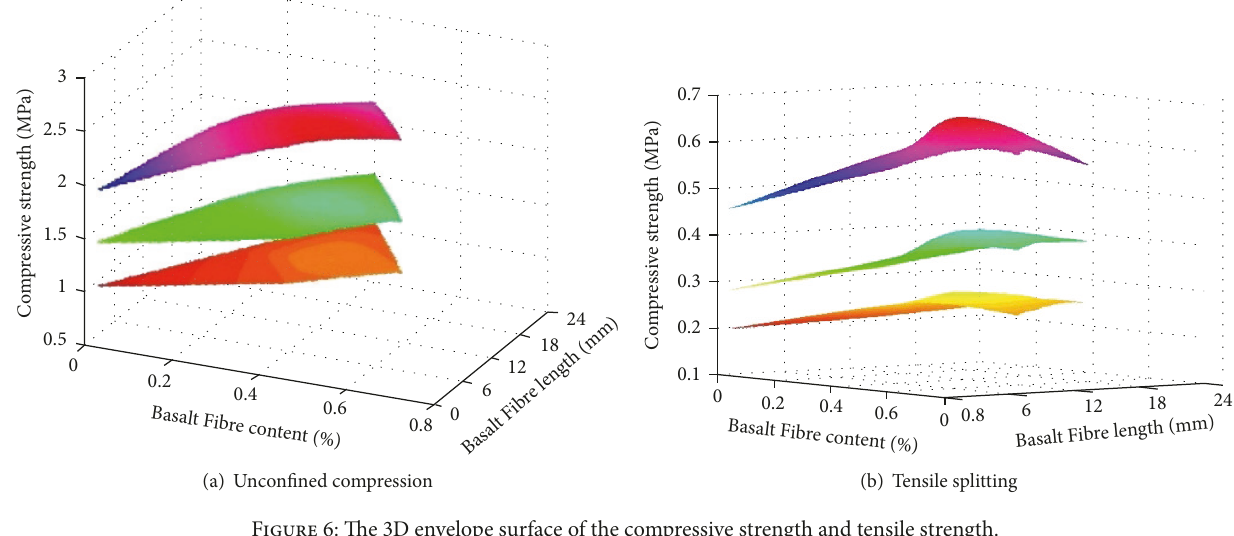
Figure 6: The 3D envelope surface of the compressive strength and tensile strength.